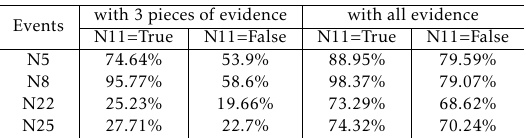
Table 5. Results of Experiment 2